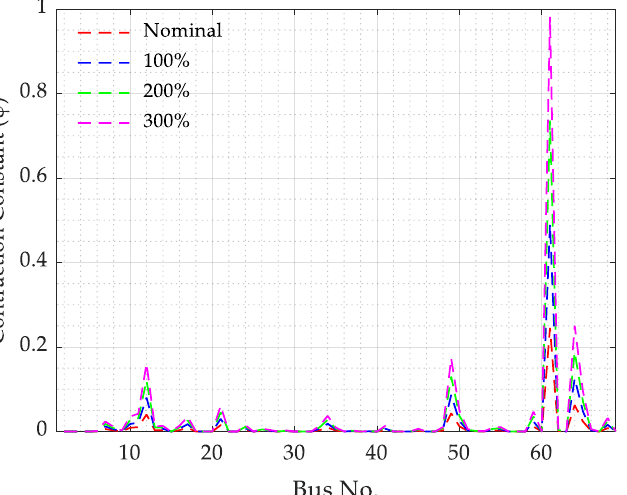
Figure 15. Value of the contraction constant for each node (69-node) for different loading conditions.